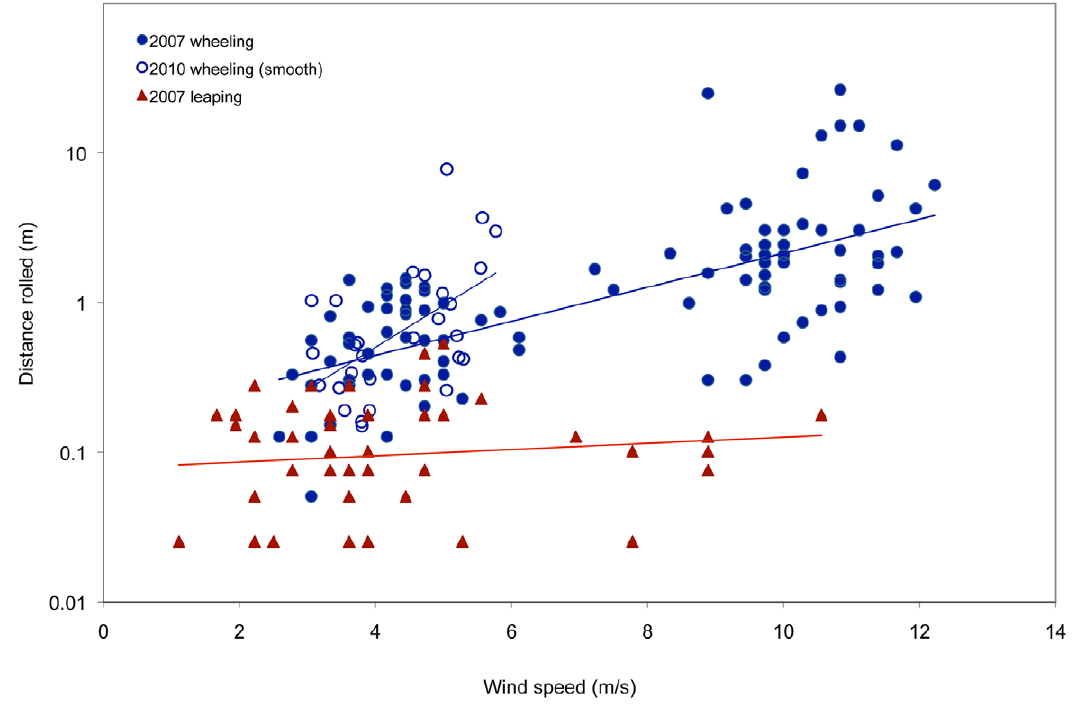
Figure 3. Effect of wind speed on distance traveled by leaping and wheeling C.dorsalismedia larvae. These trials were done on smooth beach surfaces, including all data from 2007 and from the ‘‘smooth’’ treatment in 2010.